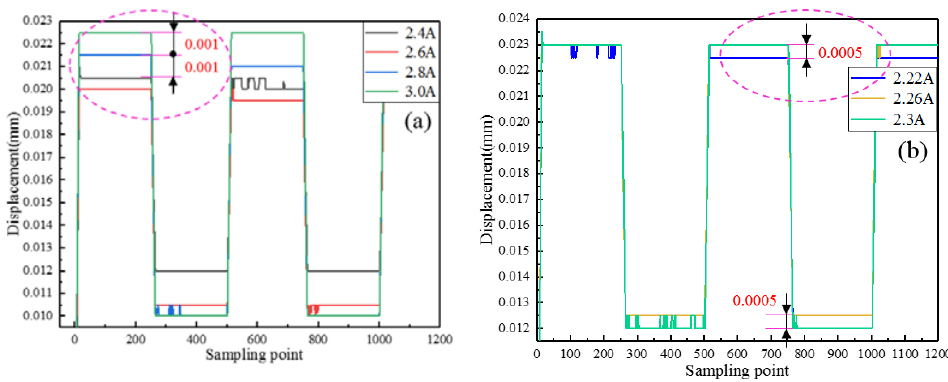
Figure 20. Resolution tests results: ( a ) 0.2A impulse response, ( b ) 0.04A impulse response.